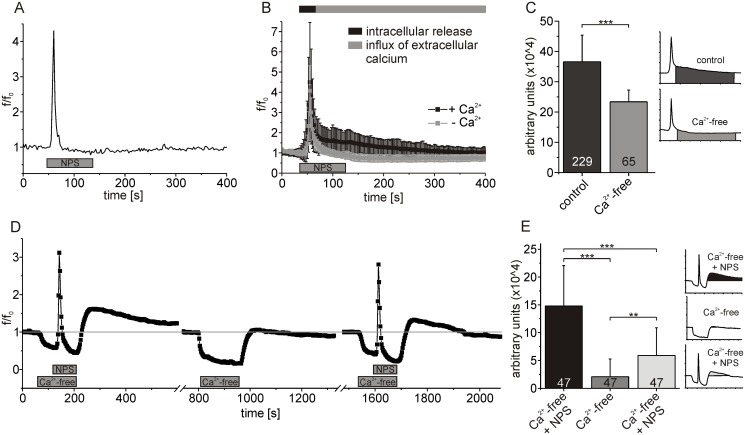
NPS application triggers store-operated calcium entry (SOCE) in neurons expressing NPSR1.(A) Single-cell fluorescence recording performed in calcium-free solution. (B) Mean fluorescence values calculated from 65 neurons under Ca2+-free conditions (grey). For comparison, control data from 229 cells are shown (black, see also Fig. 2B), unmasking proportionate contributions of intra- and extracellular calcium sources to the NPSR1-mediated calcium signal. (C) Statistical analysis of the data shown in (B). The response amplitude has been integrated over time and averaged for different experimental conditions as indicated. (D) Mean fluorescence values from 47 neurons with calcium free extracellular solution and NPS applied as indicated. Error bars have been omitted for clarification. Calcium mobilization from intracellular stores is a prerequisite for generation of the slow, extracellular component of NPSR1-mediated calcium signals. (E) Statistical analysis of the data shown in (D). The response amplitude has been integrated over time and averaged for different experimental conditions as indicated. NPS was used at 500 nM in all experiments.